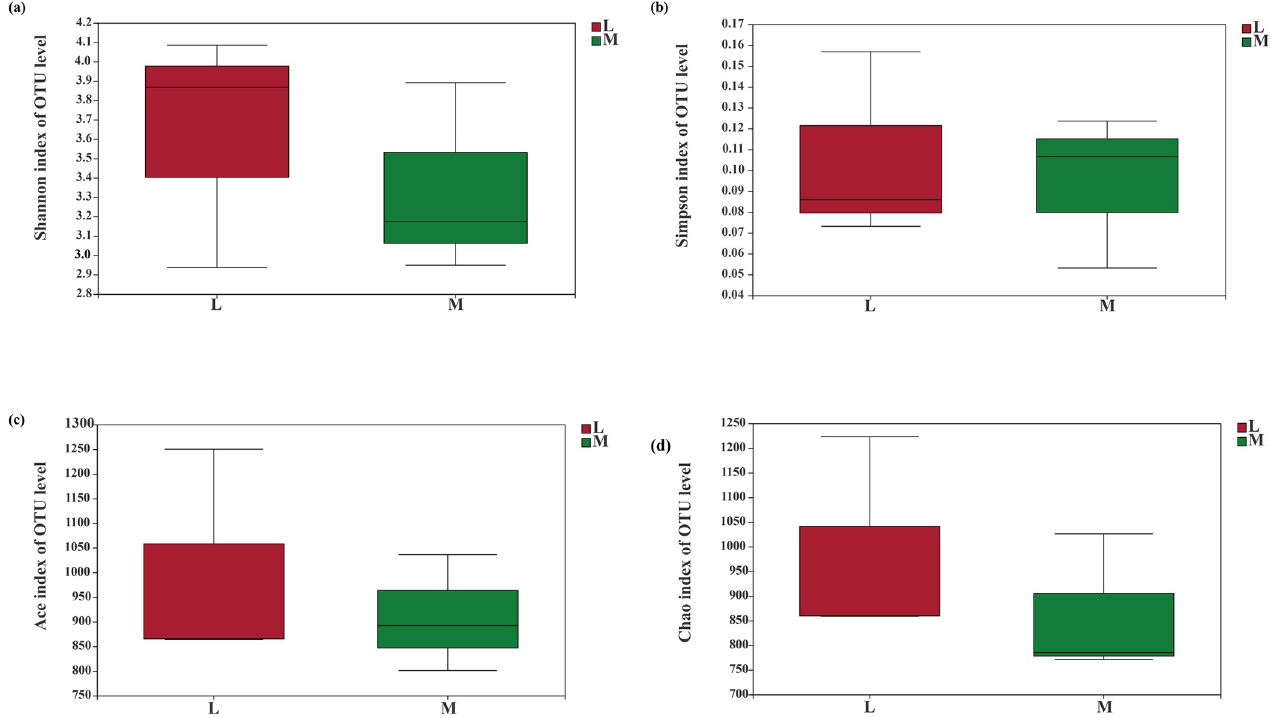
Fig 11. Soil fungal diversity and richness between moss- (M) and non-moss growth(L) areas in litchi orchard. Note : (a) Shannon index of OTU level. (b) Simpson index of OTU level. (c) Ace index of OTU level. (d) Chao index of OTU level.